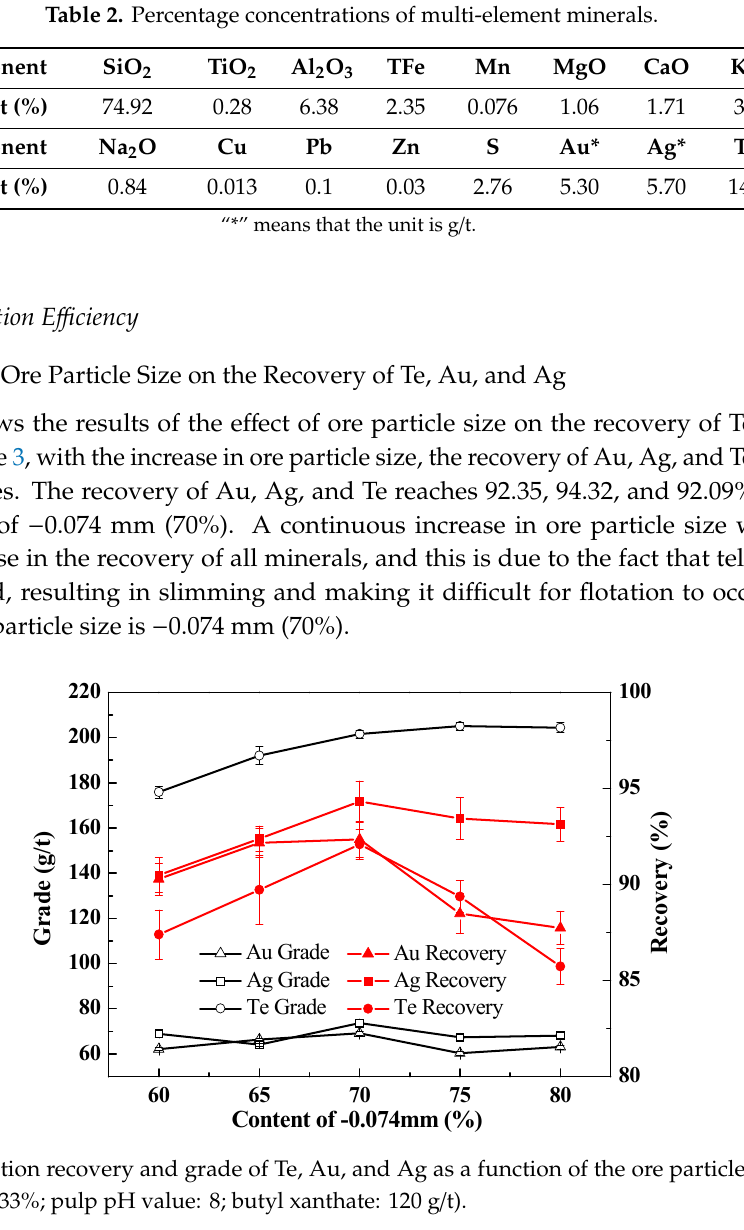
Figure 4. Flotation recovery and grade of Te, Au, and Ag as a function of pulp pH value (content of − 0.074 mm (70%); pulp density: 33%; butyl xanthate: 120 g/t).